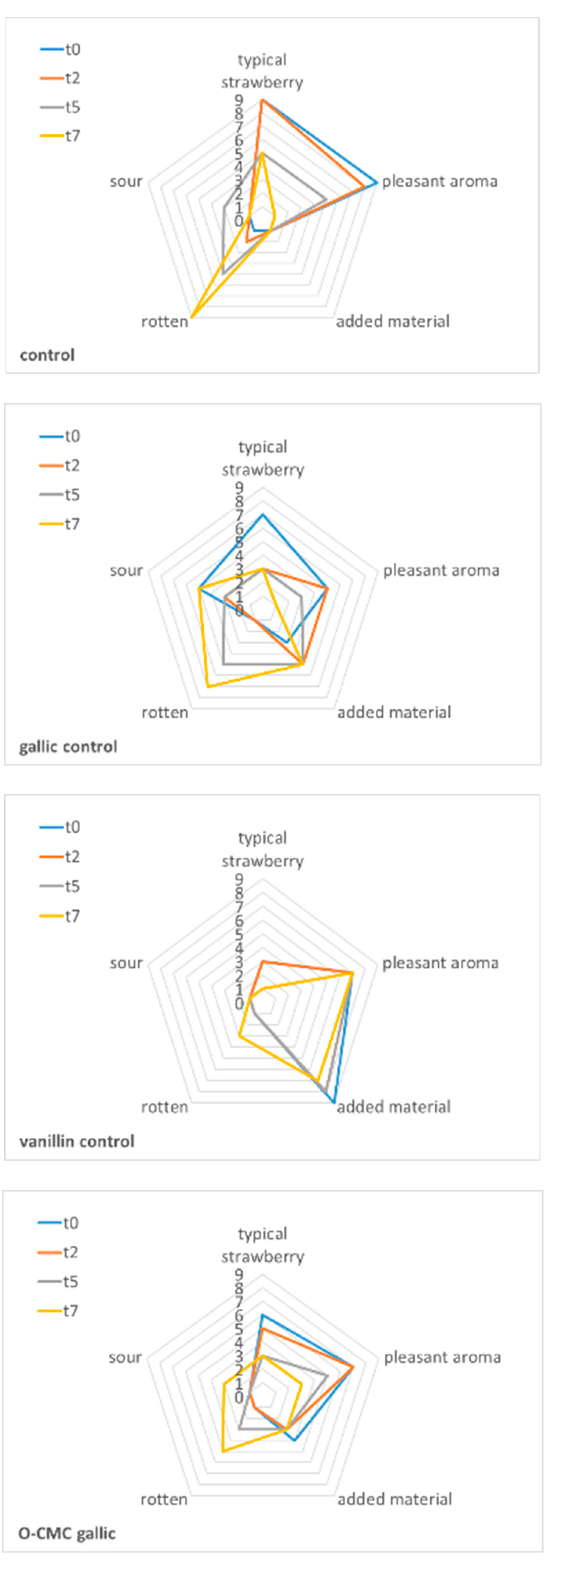
Figure 7. The effect of different treatments on the fruit aroma after 0, 2, 5, and 7 days of storage. The following olfactory descriptors were evaluated: typical strawberry, sour, rotten, added odor of active agent, and generally pleasant aroma on a scale of 1 to 9.